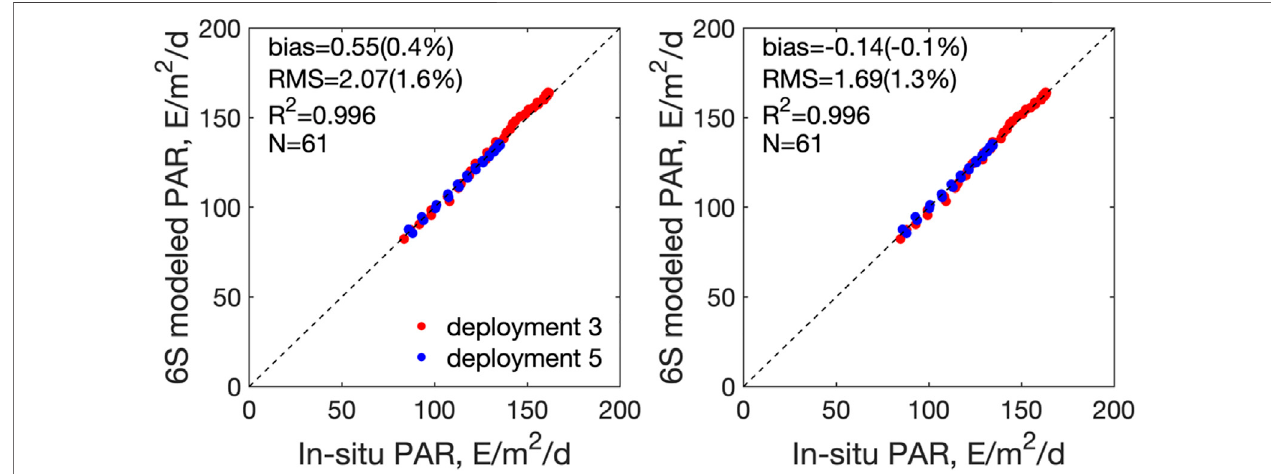
FIGURE 6 | Comparison between 6S-modeled and fi eld-measured instantaneous < E PAR > in very clear sky conditions at the BOUSSOLE site using hourly data: (Left) before any correction; (Right) after adjustment of the measured values to the 6S value via linear regression.